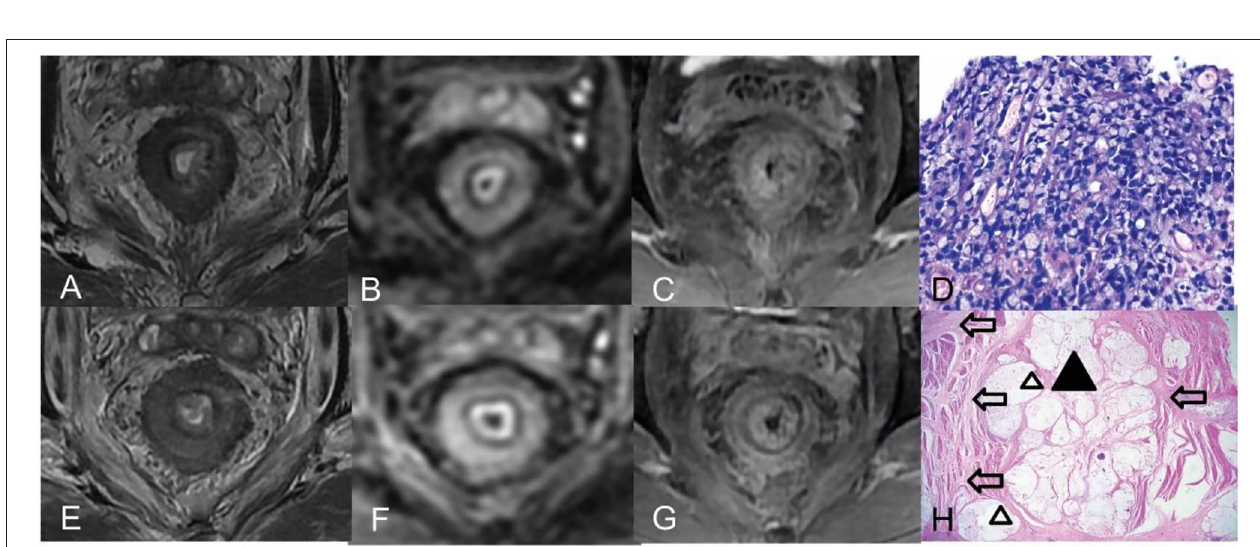
FIGURE 3 | Pre- and post-CRT rectal MR images and pathology images of a 42-year-old man (a poor responder) with RSRCC. (A–C) Axial T2WI, DWI, and contrast-enhanced T1WI pre CRT, the rectal mural showed a target sign with low SI on T2WI (A) , a thick ring sign with high SI on DWI (B) , and persistent enhancement of the entire mural layers (C) . (D) of the biopsy showed 100% of SRCs (Hematoxylin and eosin staining, × 400). (E–G) Axial T2WI, DWI, and delayed contrast-enhanced T1WI post-CRT, the lesion showed a target sign with moderate SI on T2WI with a little mucin pool on T2WI (E) , which resulted in mrTRG 4 in the evaluation of CRT response. (F,G) DWI and an enhancement pattern showed similar to the pre CRT, which indicated poor response. (H) Extensive SRCs (a black triangle) infiltrated the mural layers with detached muscular bands with fibrosis (empty arrows) and mucinous degeneration (empty triangles) (Hematoxylin and eosin staining, ×